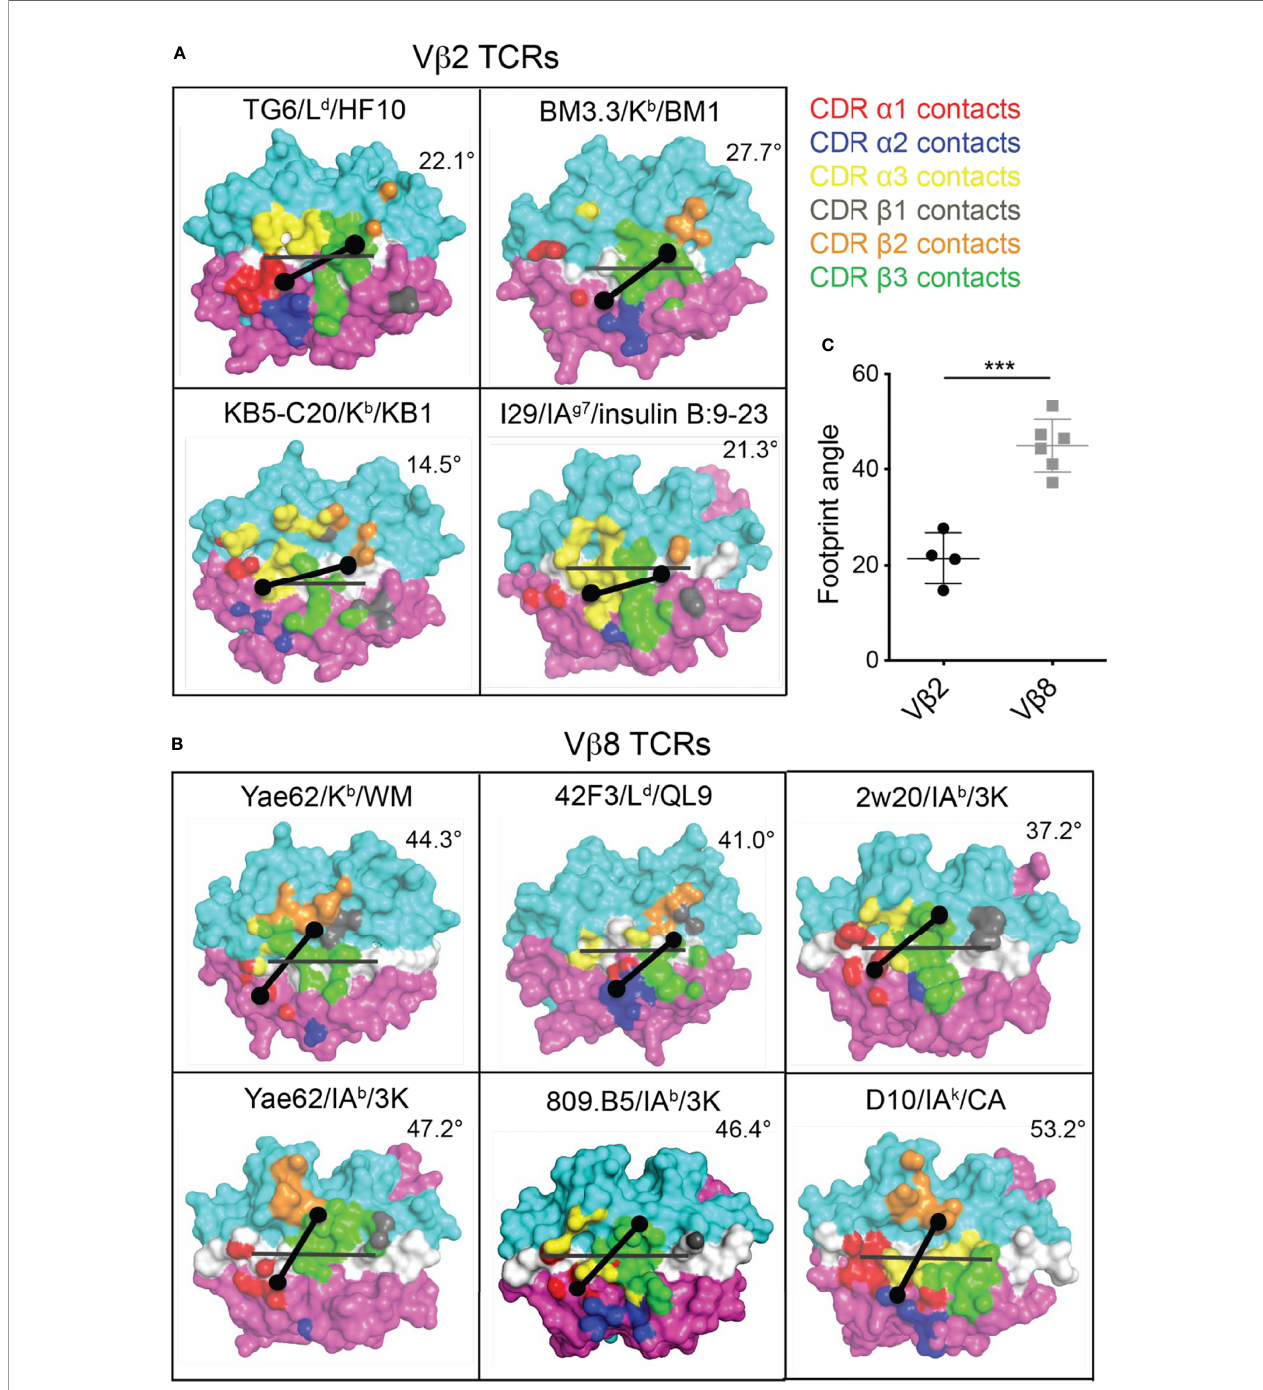
FIGURE 5 | Footprint for binding of V b 2 and V b 8 containing TCRs to pMHC. The TCR footprints for four different V b 2 TCR/pMHC complexes (A) and six different V b 8 TCR/pMHC complexes (B) are shown, along with footprint angles, calculated based on a vector for the peptide (grey line) and a vector for the TCR-pMHC contact regions (black line) as described in the text. The center of the TCR a and TCR b footprints are indicated by dots. Structures are: TG6 TCR binding to L d -HF10 (PDB: 6X31); BM3.3 TCR binding to K b -pBM1 (PDB: 1FO0); KB5-C20 TCR binding to K b -pKB1 (PDB: 1JK2); TCR I29 binding to IA g7 -insulin B:9-23 (PDB: 5JZ4); TCR Yae62 binding to K b -pWM (PDB: 3RGV);TCR 42F3 to L d -pCPA12 (PDB: 4N5E); TCR 2w20 to IA b -3k (PDB: 3C6L); TCR Yae62 to IA b -3k (PDB: 3C60); TCR ANI2.3 to DR52c-pHIR (PDB: 4H1L); TCR D10 to IA k -pCA (PDB: 1D9K). (C) Summary of all calculated V b 2 and V b 8 TCR footprint angles. Statistical signi fi cance was determined by a t-test (***p <